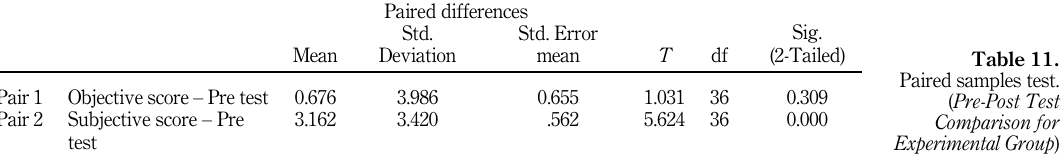
Table 10. Total effects